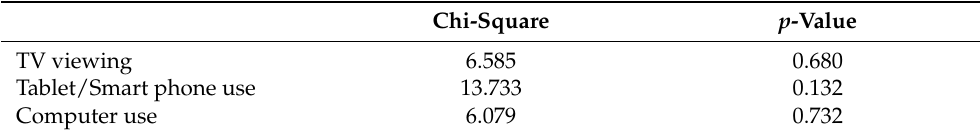
Table 4. Association between duration of technological devices use and weight status of children. Chi-Square p -Value TV viewing 6.585 0.680 Tablet/Smart phone use 13.733 0.132 Computer use 6.079 0.732